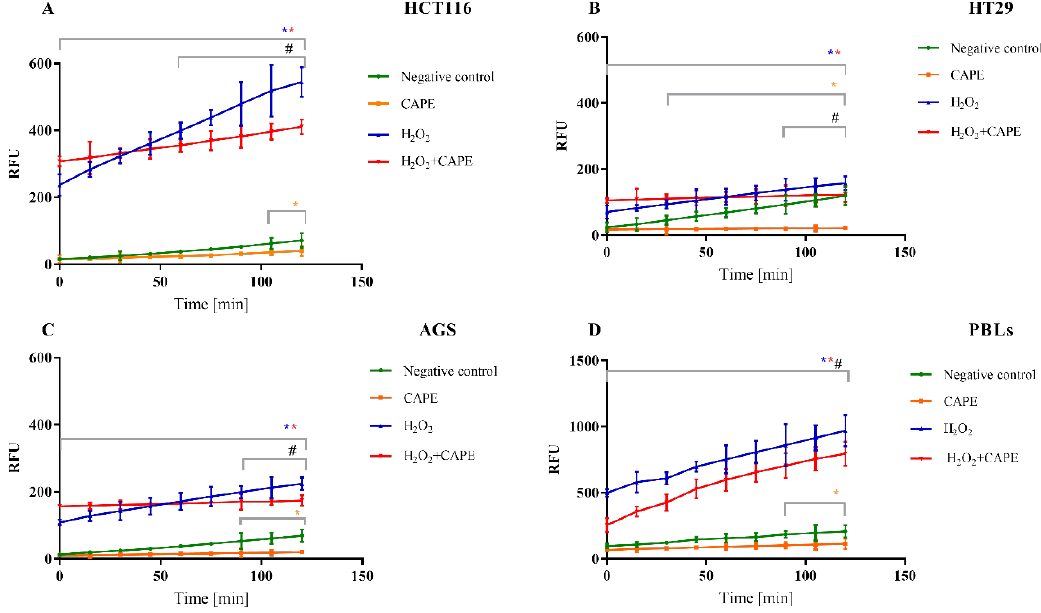
Figure 9. ROS generation in HCT116 ( A ), HT29 ( B ), AGS ( C ) cells and PBLs ( D ). The series with the preincubation with H 2 O 2 . The concentration of CAPE used in experiment was the IC 50 value determined for each cancer cell line and for PBLs were used the highest concentration from all designated. * p < 0.05 as compared with control (untreated) cells; # p < 0.05 as compared cells treated H 2 O 2 with cells treated H 2 O 2 + CAPE.